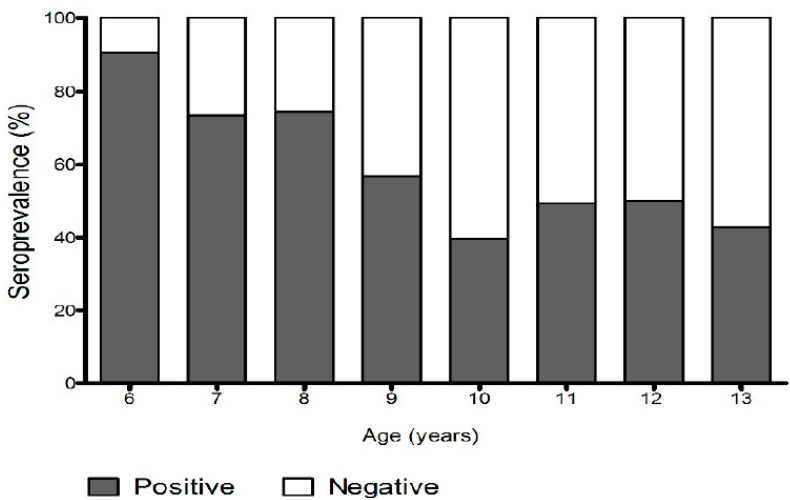
Figure 1. Distribution of positive and negative cases to IgG measles antibodies according to age. Data are reported as proportion